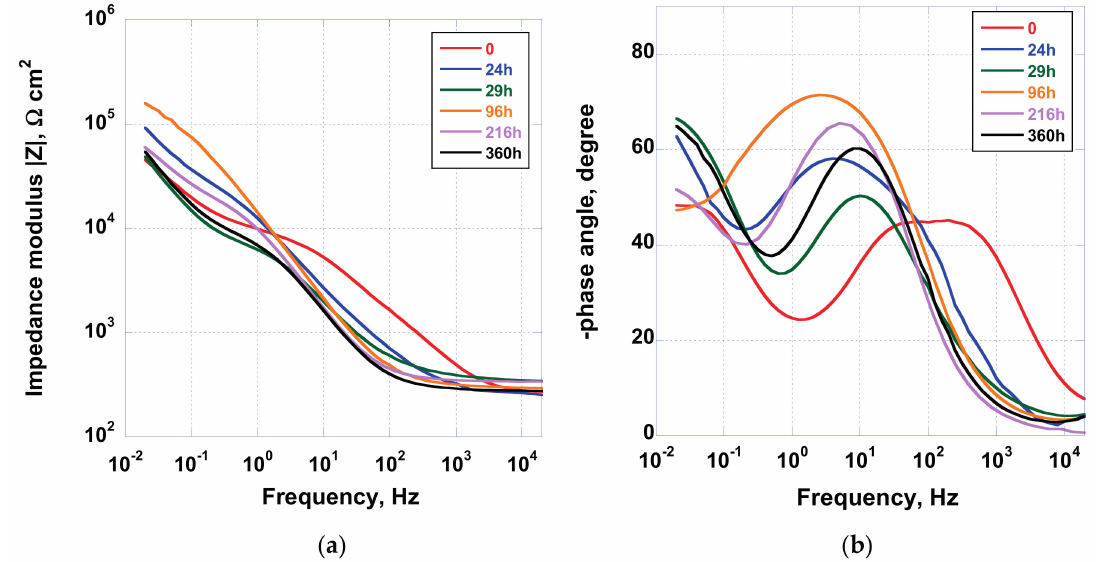
Figure 12. Bode ( a ) and phase angle ( b ) plot acquired for the sample NT when immersed in Hank’s solution for a duration of 360 h.